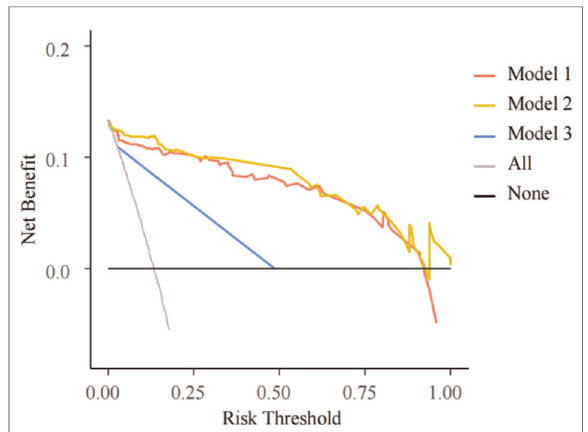
FIGURE 6 DCA for three models. The horizontal axis is the threshold probability. In the predictive model, when a patient ’ s probability of phototherapy failure reached the threshold, it was deemed that the phototherapy had failed and exchange transfusion therapy (ETT) was ordered. The vertical axis is the net bene fi t (NB), bene fi ts of ETT after phototherapy failure minus the damage due to ETT despite successful phototherapy and the damage resulted from ETT not performed after phototherapy failure. The black solid line from 0.0 on the vertical axis represents 0 NB where phototherapies are successful for all patients, who require no ETT. The black oblique line is where ETT is required for every patient after all of their phototherapies fail. The curves are compared with the two reference lines of the extreme scenarios. The closer a curve is to the two reference lines, the less value the model has in application. A model is preferable when it is above the reference lines with a larger threshold range. NB is a backslash with a negative slope. A model is better with a greater NB under a given threshold.